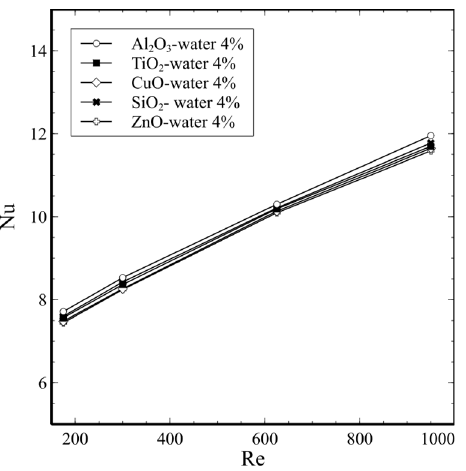
Figure 5. Comparison of Nu for water-based nanofluids at φ b = 4%.